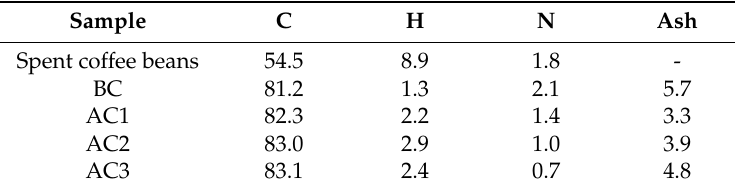
Table 2. Ultimate analysis of samples (% by mass on a dry basis).